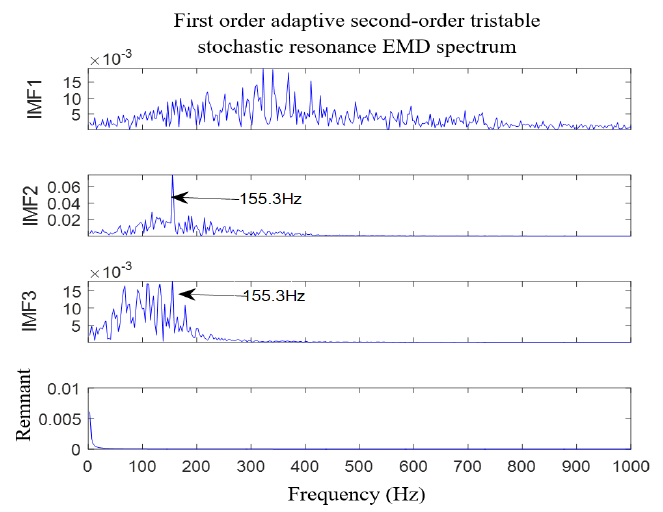
Figure 20. The processing results of the first cascaded stochastic resonance.